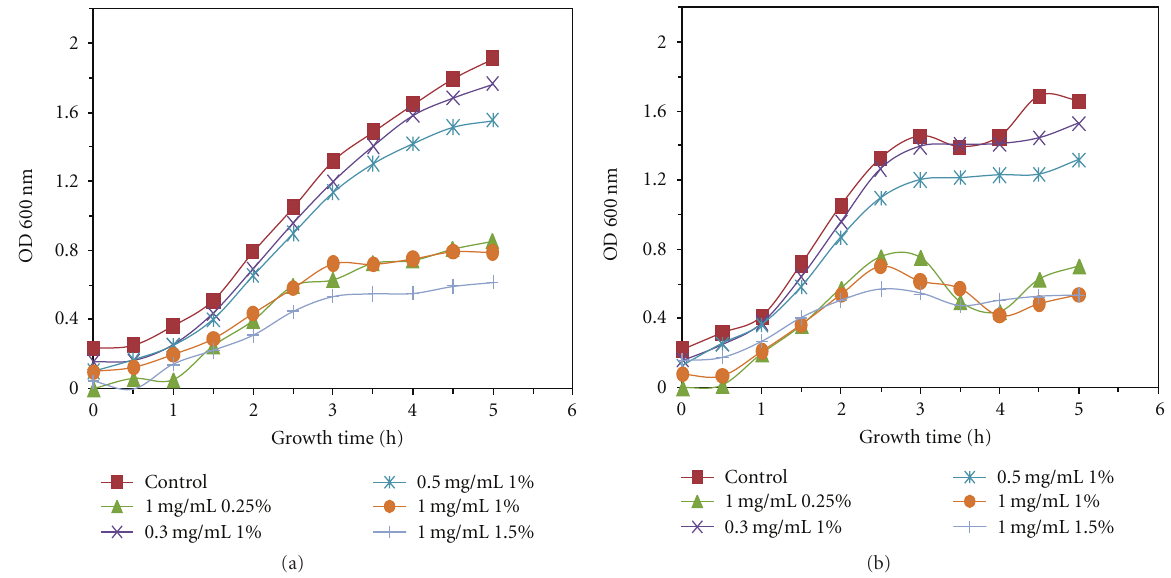
Figure 4: OD growth curves of (a) S. enterica and (b) E. coli after treatment with SWCNT + surfactant solutions and incubation for 1h. The legend shows SWCNT concentration in mg/mL and SC surfactant concentration in %. A blank containing the same SWCNT concentration as the experimental sample was subtracted from each of the SWCNT-containing data sets in order to measure absorbance created by cells. Other conditions are the same as in Figure